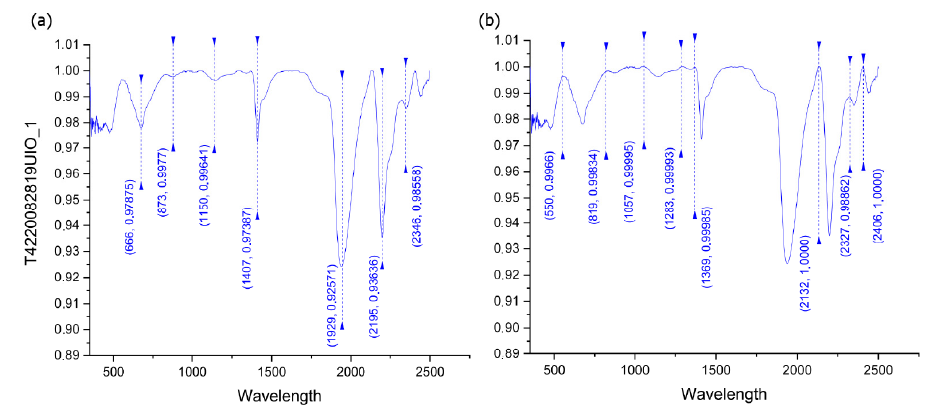
Figure 13. Absorption and reflectance peaks from spectra collected from pegmatite quartz samples of Tysfjord. ( a ) Main absorption peaks (minimum). ( b ) Main reflectance peaks.